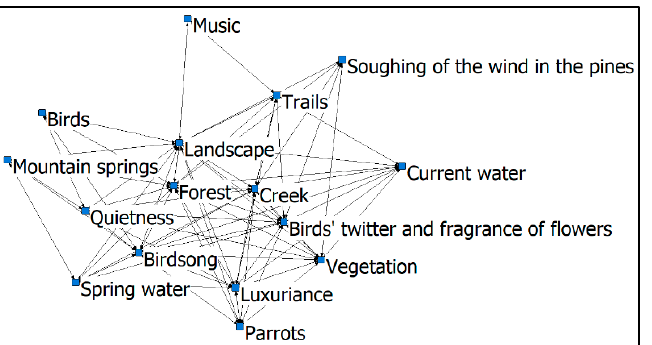
Figure 10. 2-1. Urban forest park elements based on audio-visual interactive perception.